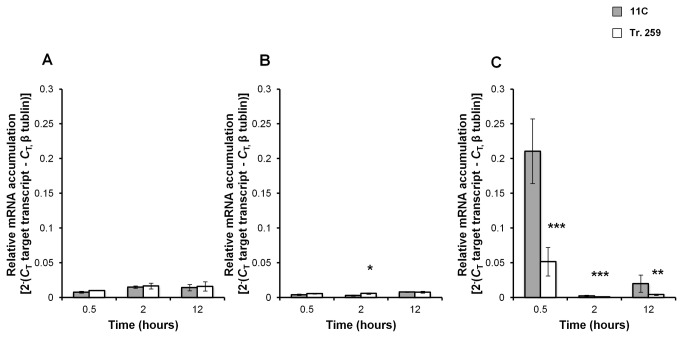
RT-PCR analysis of putative hexose transporter under alcohol stress.Temporal analysis of putative hexose transporter transcript (FOXG_09625) during shake flask growth of Fusarium
oxysporum strain 11C and transformant Tr. 259 under normal conditions (A), ethanol stress (B) and butanol stress (C). F. oxysporum (2ml 106 ml-1) was aerobically cultured in Erlenmeyer flasks (100 ml) in 48 ml of minimal medium [37] for 12 hours shaking at 150 rpm at 25°C. At 12 hours, flasks were amended with 2ml of water, ethanol or butanol to a final concentration of 0%, 4% and 0.75% (vv-1), respectively. RT-PCR was conducted on RNA samples harvested at 0.5, 2, 12 hours respectively post – inoculation. Putative HXT accumulation was quantified relative to the housekeeping gene β-tubulin (FOXG_06228) [38] Results are based on three experiments (no alcohol, ethanol) or two experiments (butanol), each with three replicates per time point per strain tested. RT-PCR was conducted twice on each experiment. Bars indicate SEM. Tr. 259 FOXG_09625 mRNA accumulation significantly different from strain 11C is highlighted with an asterisk (level of significance: *<0.05, **≤ 0.01, ***< 0.001).